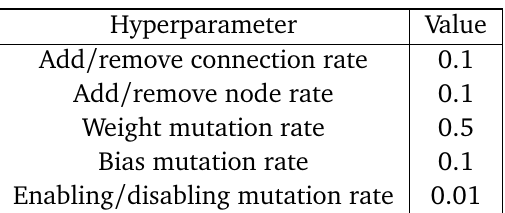
Table 2: Mutation rates